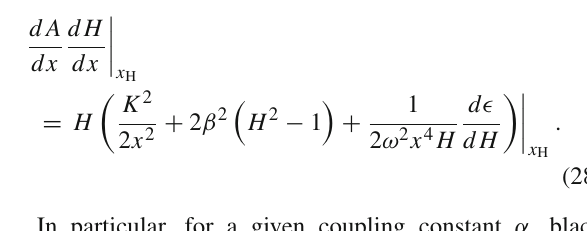
Fig. 4 The (normalized) mass of the EYMH black hole solutions (cid:13) m ∞ /α 2 as a function of horizon radius x 1 . 0, together with the corresponding RN solutions with unit magnetic charge (dashed lines)